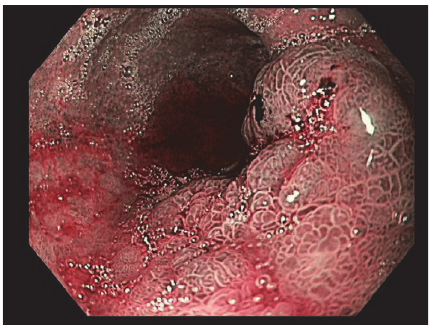
Figure 6: Patient 2 (NBI). New esophageal